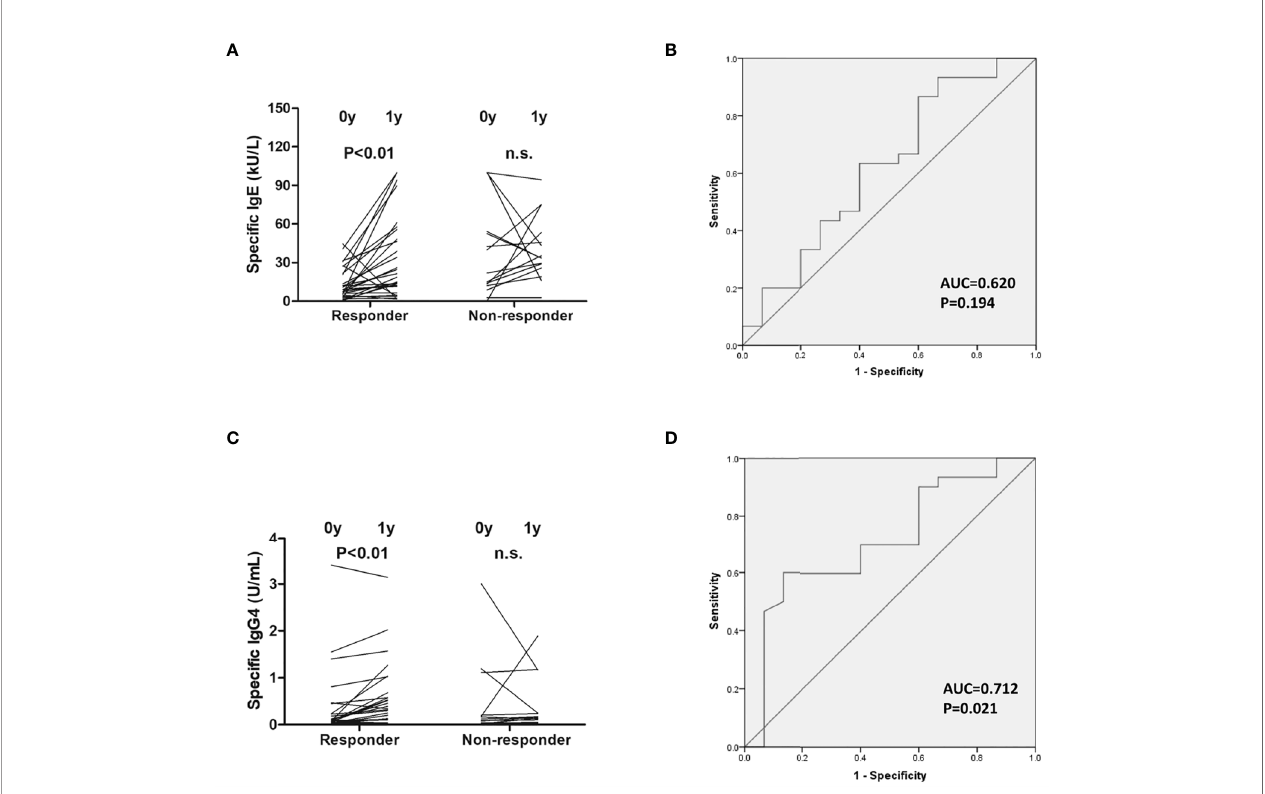
FIGURE 2 | Measurements of serum immunoglobulin level. Artemisia -sIgE (A) and Artemisia -sIgG4 (C) in the sera of responders and non-responders before and after 1-year allergen immunotherapy (AIT) were measured as described in the Methods section. Receiver-operator characteristic (ROC) curve of Artemisia -sIgE (B) and Artemisia -sIgG4 (D) in the sera of responders and non-responders. n.s., not signi fi